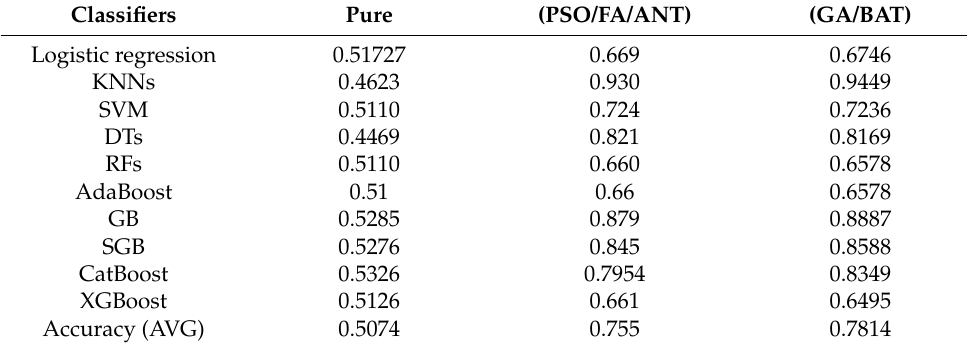
Figure 3. The total number of selected features utilizing metaheuristics algorithms. Table 5. Classifier testing accuracy results over metabolic dataset utilizing metaheuristics.